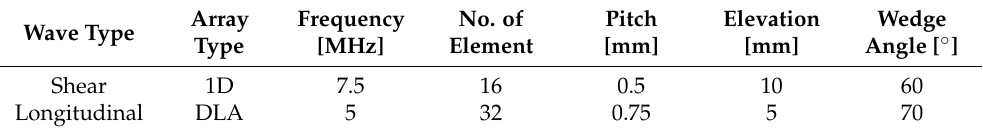
Table 4. Specification of PA Probe and Wedge.